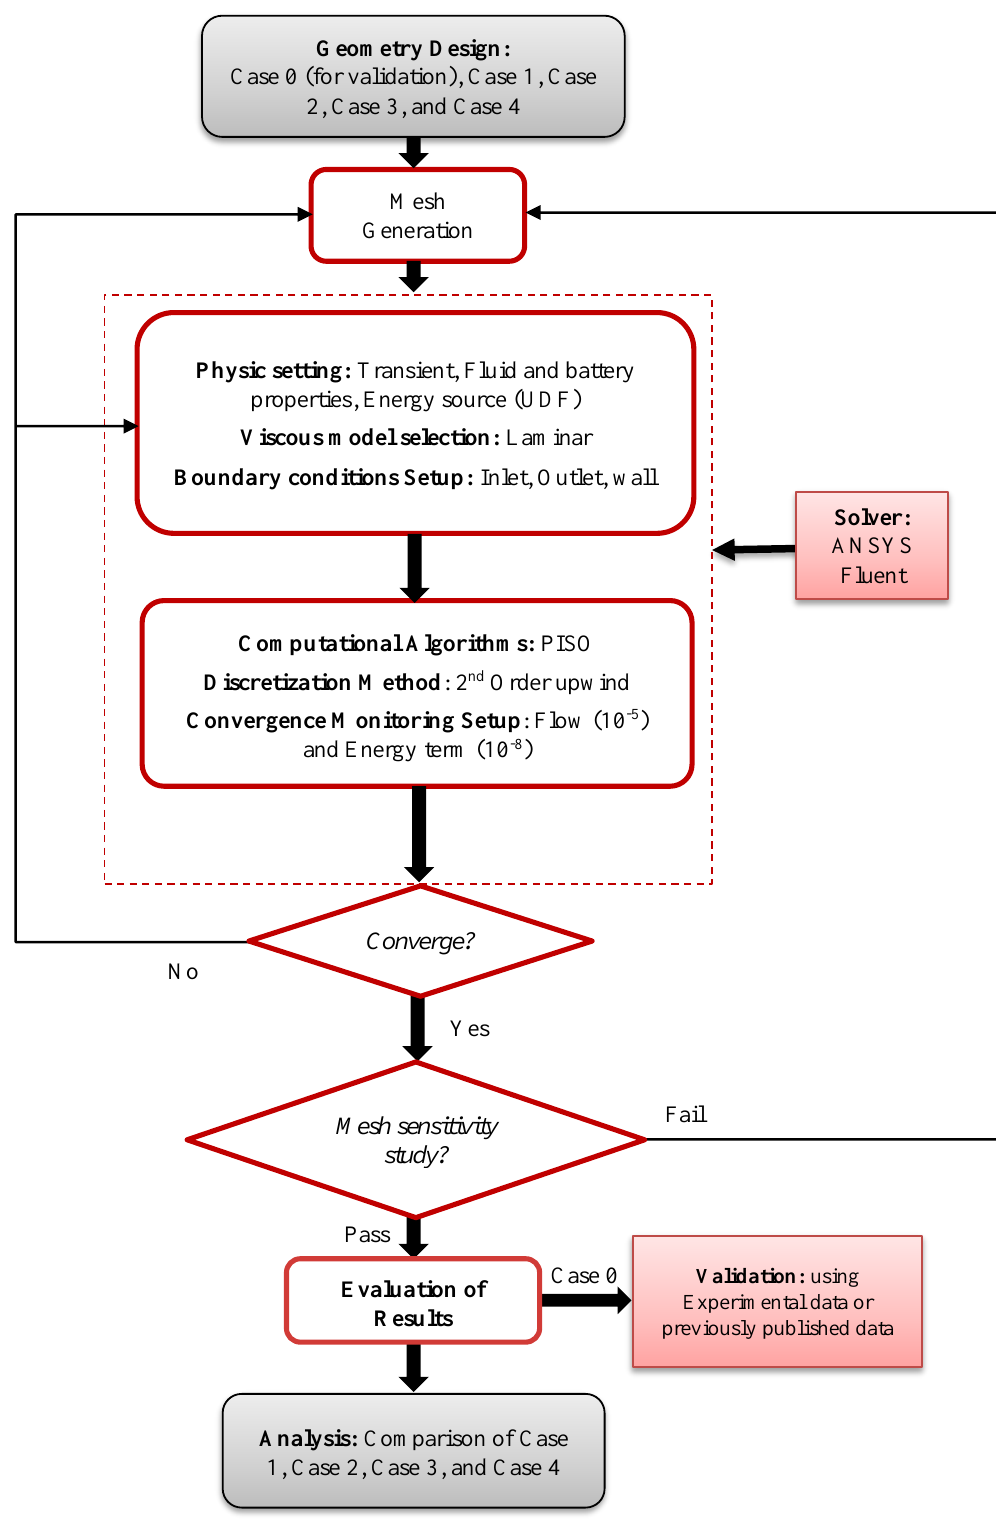
Figure 5. Methodology